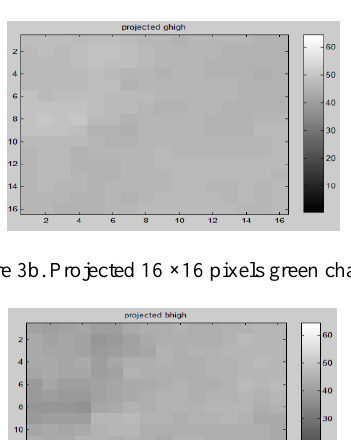
Figure 3a. Projected 16 ×16 pixels red channel